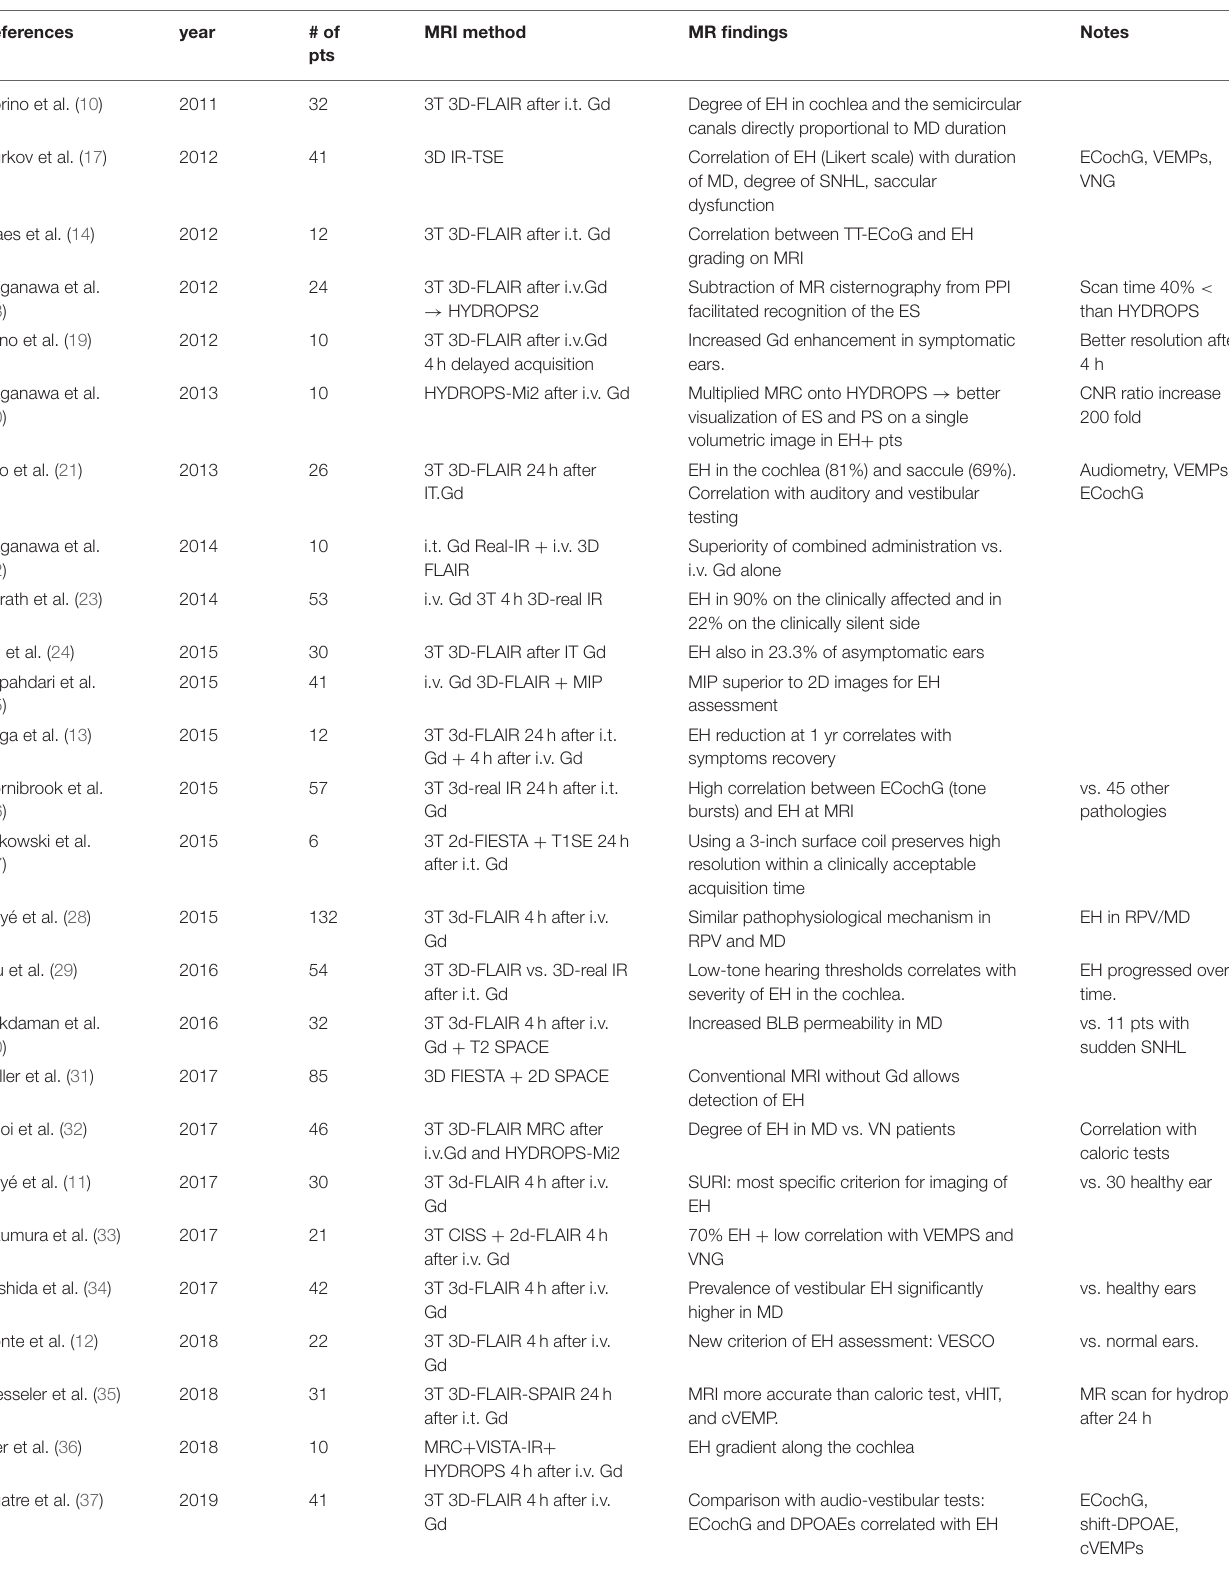
TABLE 1 | Summary of literature review (last decade) on MRI in Meniere’s disease